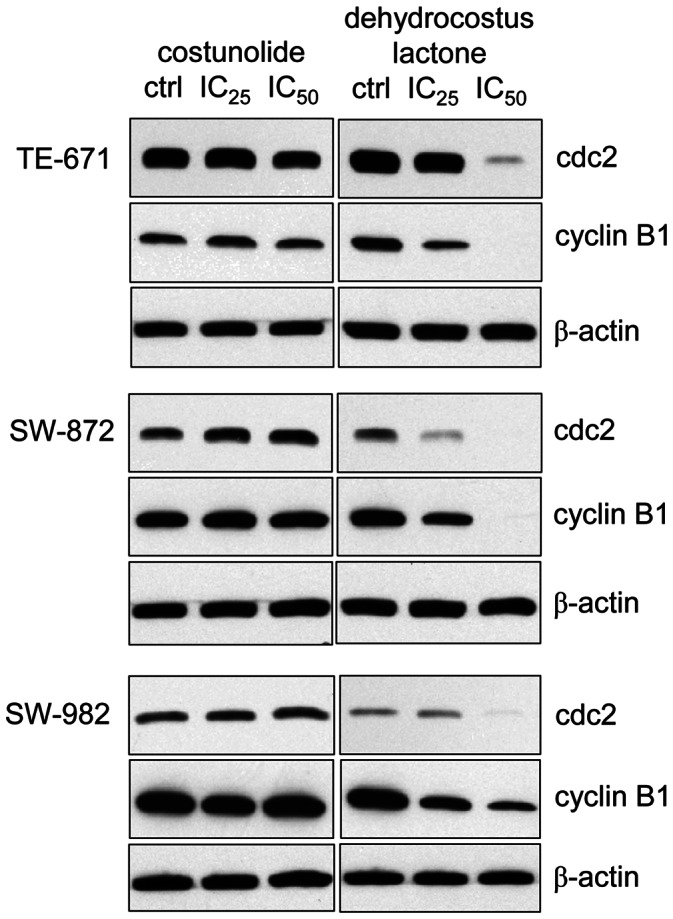
Western blot analysis of G2/M arrest regulator proteins.Total protein analysis revealed a significant downregulation of cdc2 and cyclin B1 in dehydrocostus lactone treated STS cells, whereas, costunolide treatment did not affect the protein levels of these G2/M checkpoint regulators. β-actin was used as loading control. Data shown are representative from at least three independent experiments.